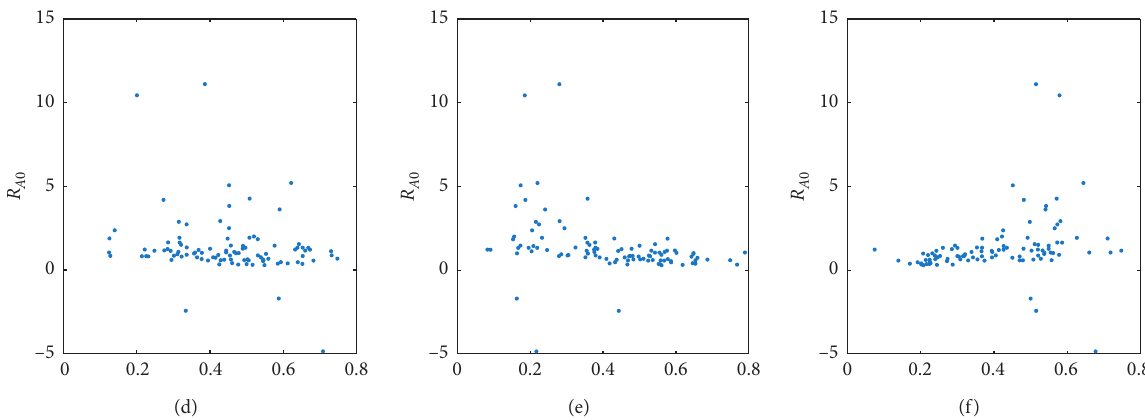
Figure 9: Scatter plots for the basic reproduction number R A 0 and six sampled input parameters’ values. These results have been obtained from Latin hypercube sampling using a sample size of 100. (a) β 1 . (b) β 2 . (c) α 1 . (d) α 2 . (e) c 1 . (f) c 2